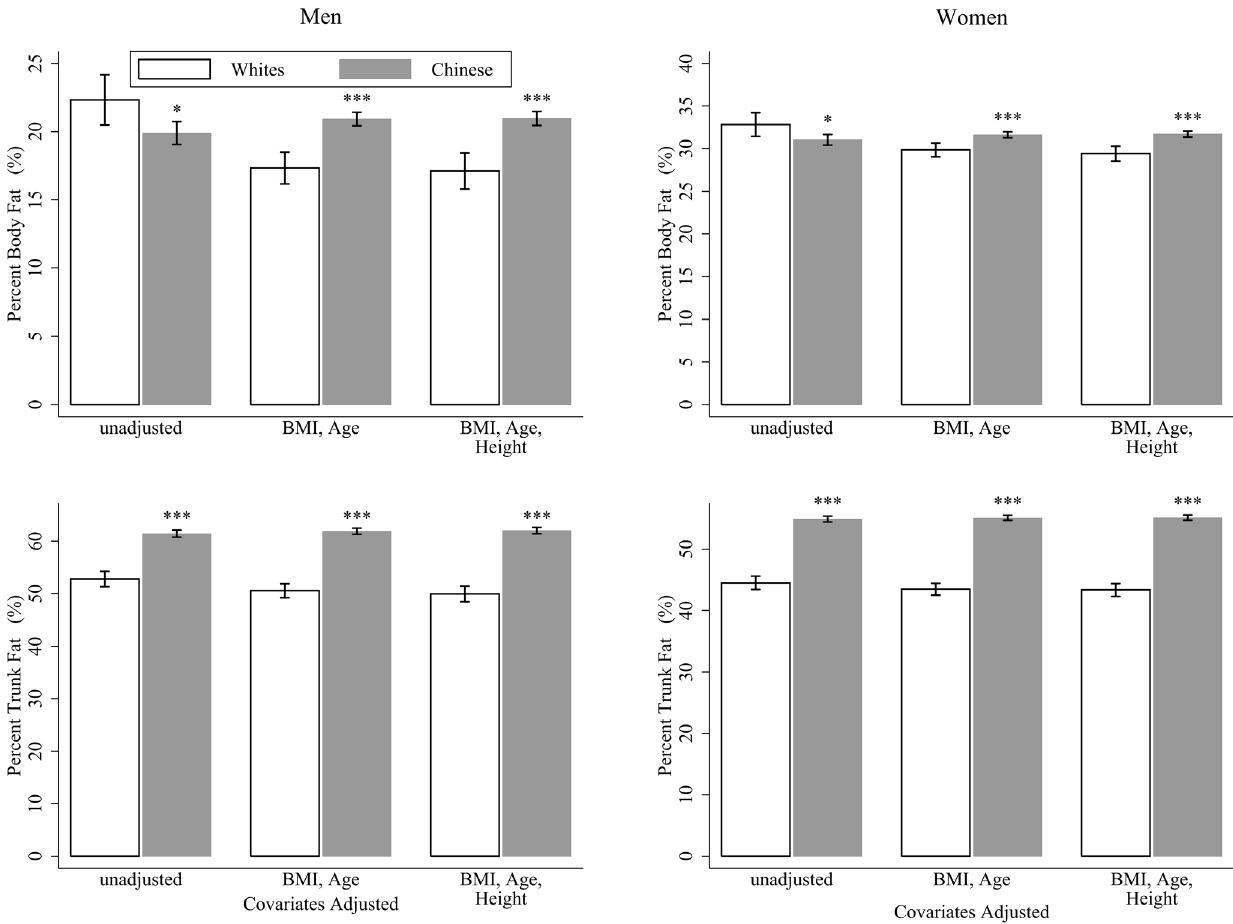
Figure 2. Percentage body fat and percentage trunk fat by ethnicity in men and women. Error bars represent 95% confidence intervals. Data were analyzed by using analysis of covariance (ANCOVA) with ‘‘ethnicity’’ as the grouping variable and the listed variables as covariates. BMI, body mass index. * p , 0.05, ** p , 0.01, *** p , 0.001, for the difference with white men or women, respectively.